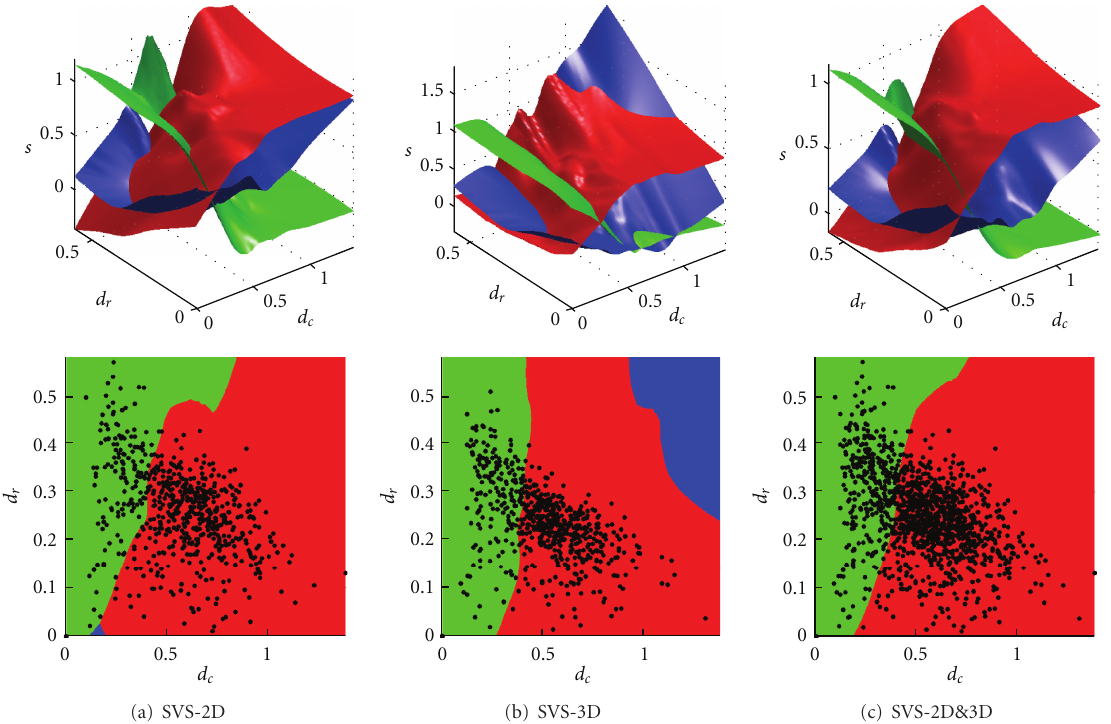
Figure 4: (Top) Scoring surface functions in the space ( d c , d r , s ) and (bottom) SVS selection regions in the space ( d c , d r ), where each method among STAPLE (red), Vote (blue), and SBA (green) gives the highest score, for (a) SVS-2D, (b) SVS-3D, and (c) SVS-2D&3D. The bottom images correspond to the top views of the surfaces presented above. The overlaid scatter plot represents the ( d c , d r ) values of the tests for each SVS version’s training